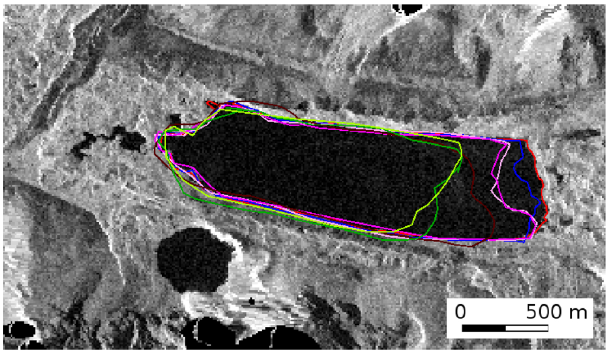
Fig. 8. Outlines of Imja Tsho derived from ERS-1/2 SAR data of May 1992 (light green), April 1996 (green), July 2001 (brown), ALOS PALSAR data of November 2007 (violet), May 2008 (pink), and TerraSAR-X data of April 2009 (blue) and October 2009 (red). Background image is the TerraSAR-X data of October 2009.